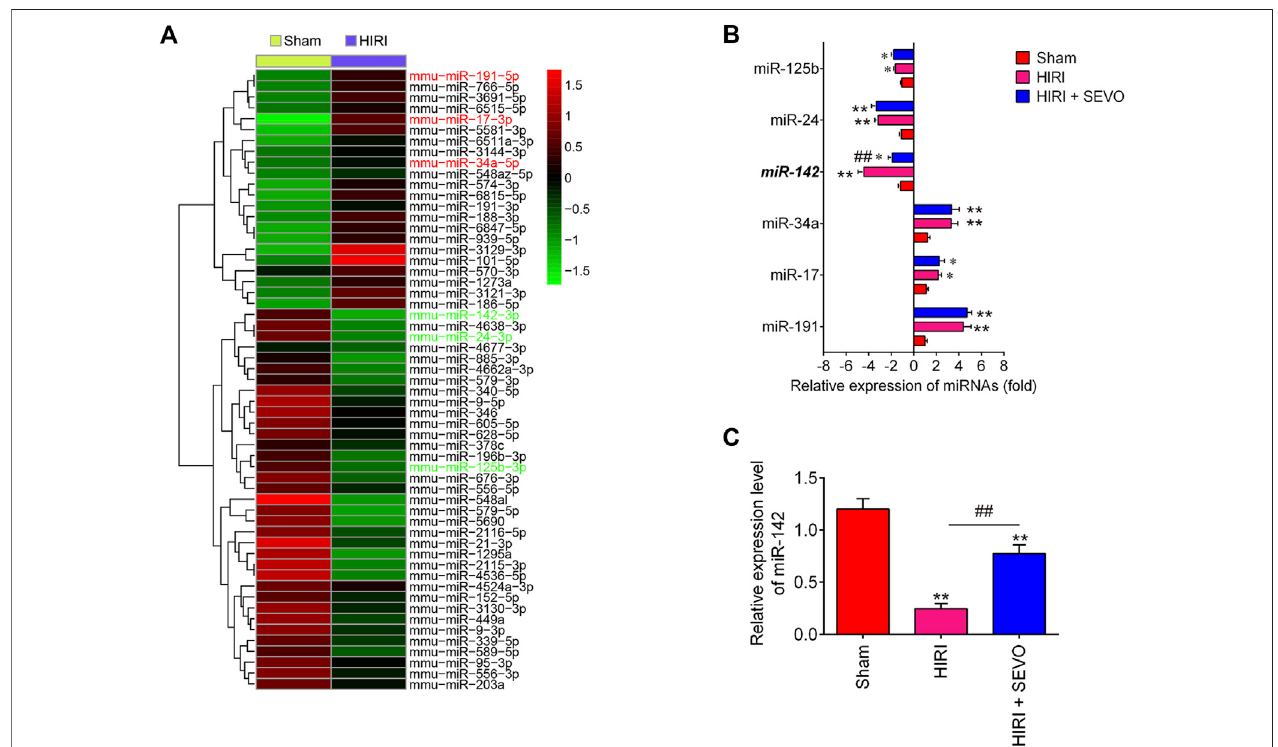
FIGURE 3 | Sevo fl urane postconditioning reverts I/R-induced downregulation of miR-142. (A) Heat map analysis of the miRNAs expression of groups (HIRI and Sham) was created using a method of hierarchical clustering by GeneSpring GX, version 7.3. Rows: Groups; Columns: microRNAs; Color key indicates microRNA expression value, red: Highest, green: Lowest. Microarray data obtained from GEO, GSE number is GSE72314. (B) The expression levels of miR-125b, miR-24, miR- 142, miR-34a, miR-17, and miR-191 were detected in Sham, HIRI, and HIRI + Sevo groups by qRT-PCR ( n (cid:2) 6/group). (C) The expression of miR-142 was measured in Sham, HIRI, and HIRI + Sevo groups by qRT-PCR in 6 mice/group. All data were measurement data which were expressed as mean ± standard deviation and analyzed by one-way analysis of variance. * p < 0.05, ** p < 0.01 vs. Sham group; ## p < 0.01 vs. HIRI